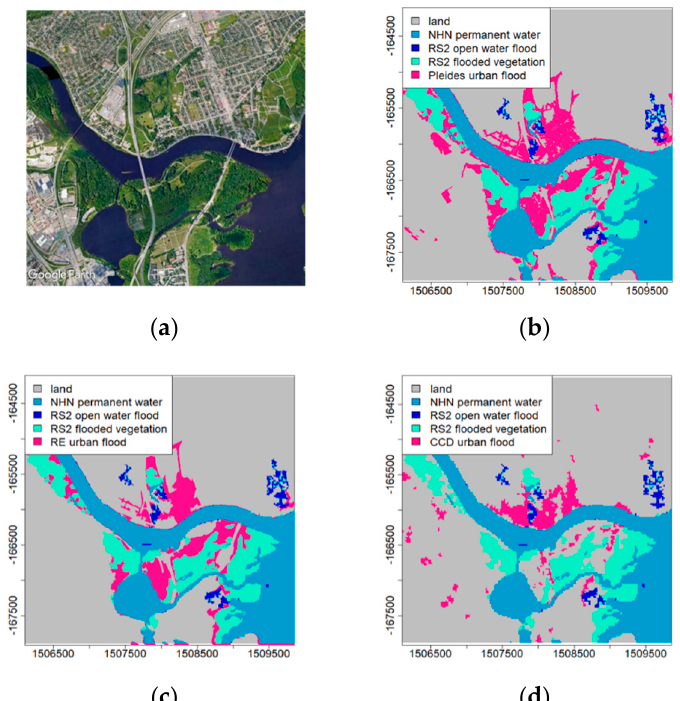
Figure 8. Gatineau: ( a ) High-resolution natural colour image from GoogleEarth TM ; ( b ) urban flood extents derived from a Pleiades-1B NIR image acquired on April 28, 2019; ( c ) urban flood extents derived from a RapidEye-5 image acquired on May 5, 2019; ( d ) CCD urban flood extent derived from γ post and γ co. The background classification for panels b-d is an EGS RS2 flood map from April 30, 2019. Note that urban flooding refers to floodwaters detected in high-resolution optical imagery or CCD and not in